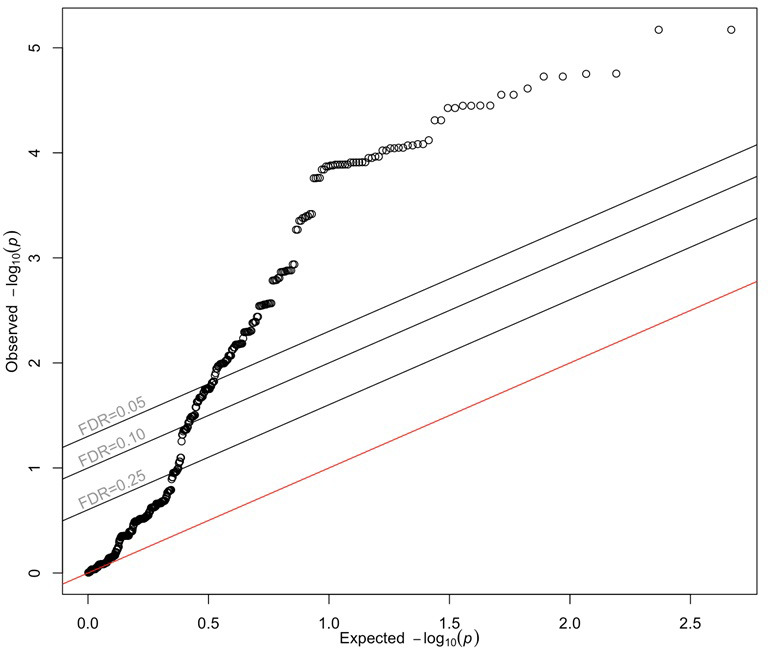
QQ plot of diabetic retinopathy meta-GWAS p-values corresponding to 272 folliculin (FLCN) eSNPs.Points represent observed and expected GWAS-meta-analysis p-values for each of 272 FLCN eSNPs identified in the retina and more than 20 GTEx tissues. The red line represents the null hypothesis of no difference between the observed and expected p-values. Source and code files for this plot are available in Figure 4—source data 5 and Source code 14.